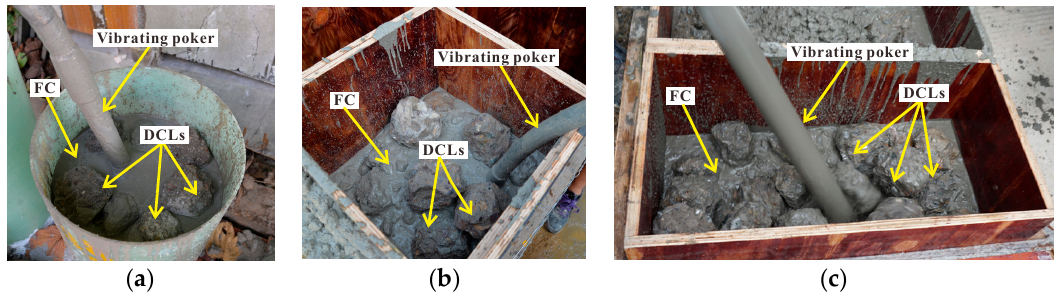
Figure 4. Concrete casting of specimens: ( a ) cylinders; ( b ) cubes; ( c ) prisms.